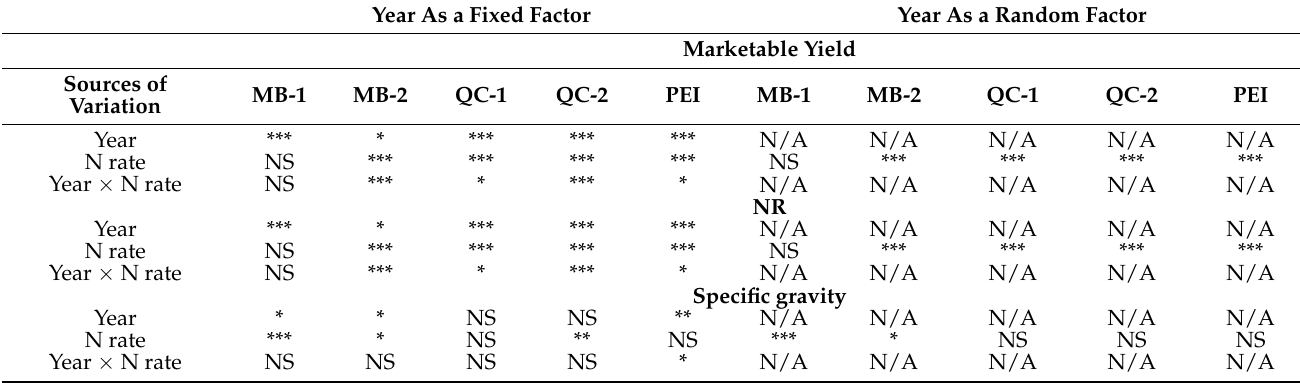
Table 6. Analysis of variance of the effects of N rate on marketable yield, specific gravity and NR, treating year as a fixed or random